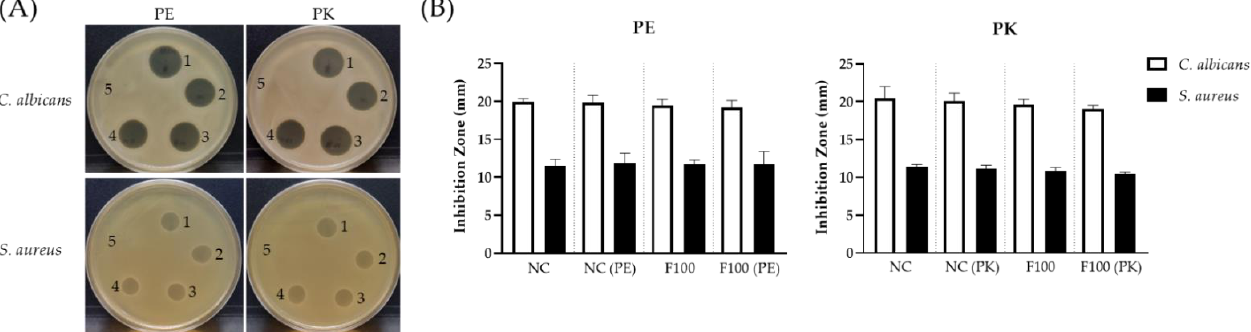
Figure 6. Protease Treatment of AF1 and F100 from SC263. ( A ) Antibiotic activities of AF1 and F100 individually treated with pronase E (PE) or proteinase K (PK) were examined. Numbers in this image indicate different treatment conditions as below. 1: AF1. 2: F100. 3: AF1 treated with PE or PK. 4: F100 treated with PE or PK. 5: PE or PK in sterile water. ( B ) The diameters of inhibition zones were measured.